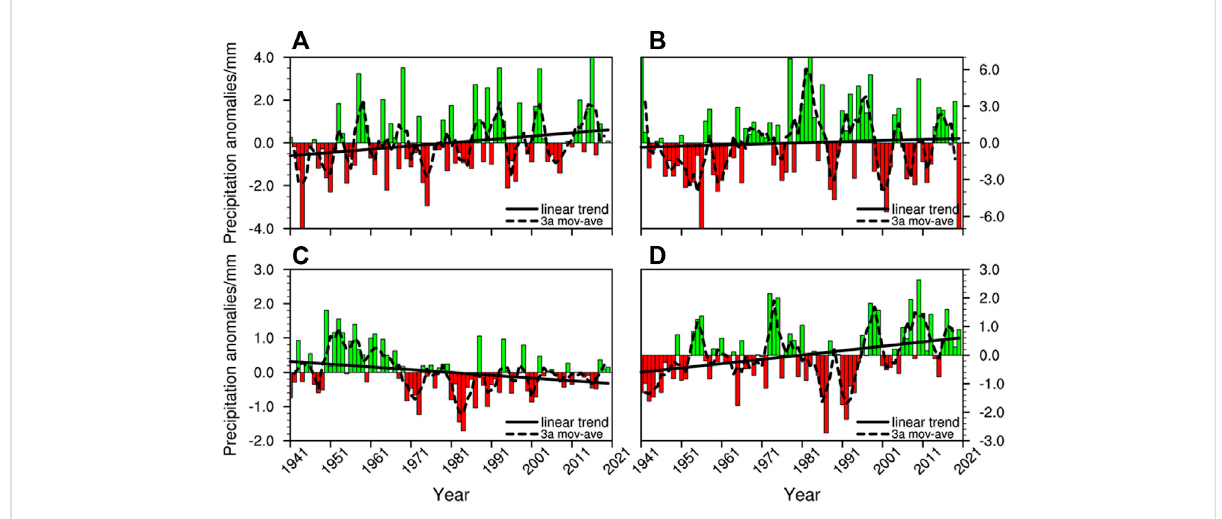
FIGURE 2 The 3-year moving averages of precipitation anomalies in the three typical arid regions of (A) PCA, (B) NAm and (C) NAf and (D) the global from 1941 to